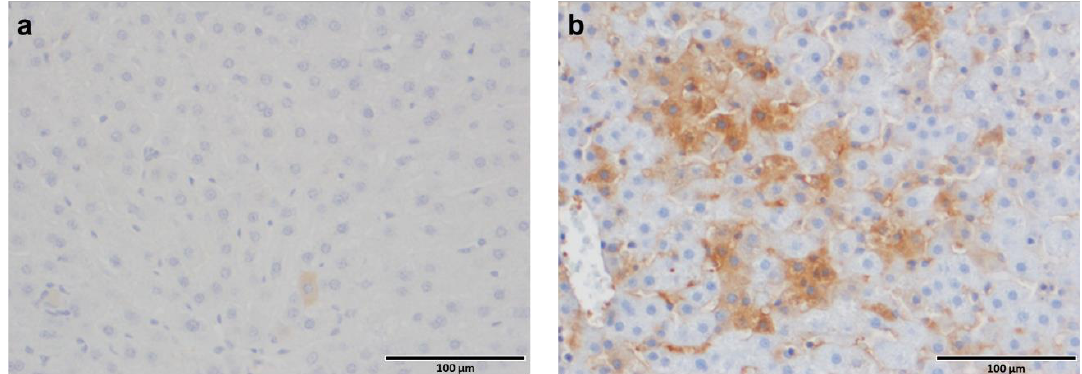
Figure 6. The presence of vi-VIM is strongly increased in the liver of WHV-infected woodchucks. Liver of one woodchuck ( a ) without WHV-infection and ( b ) with chronic WHV-infection was stained with hzVSF by IHC for the detection antibody-bound